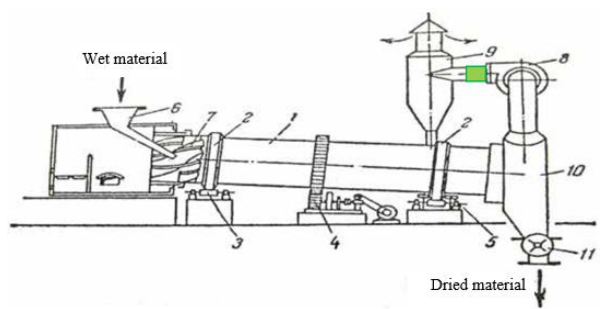
Fig. 3. Principle of operation of the drying drum (1 - drum; 2 - bandages; 3 - support rollers; 4 - transfer; 5 - support rollers; 6 - feeder; 7 - blades; 8 - fan; 9 - cyclone; 10 - unloading chamber; 11 - unloading